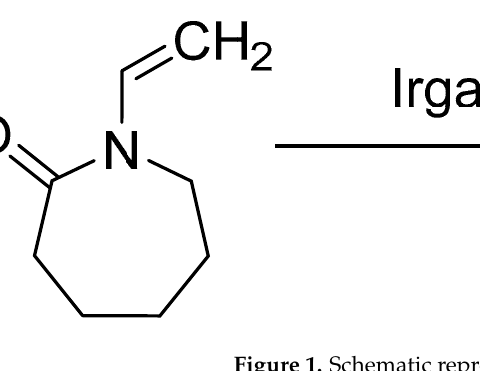
Figure 1. Schematic representation of the photopolymerisation process of NVCL to PNVCL in the presence of Irgacure ® 2959 [36].